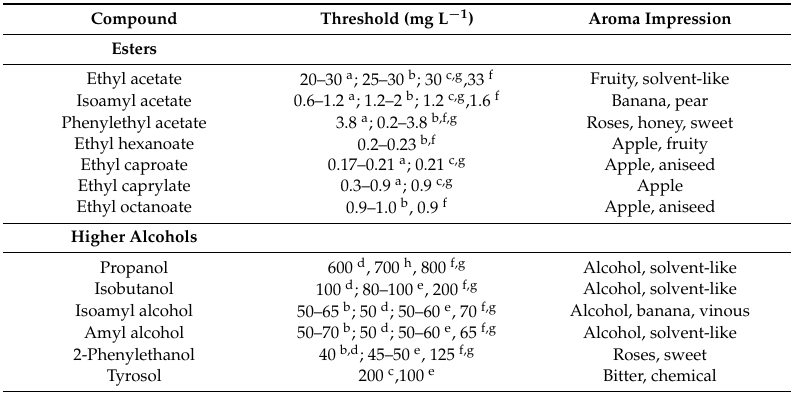
Table 5. Threshold values and aroma impressions of the most important esters and higher alcohols present in